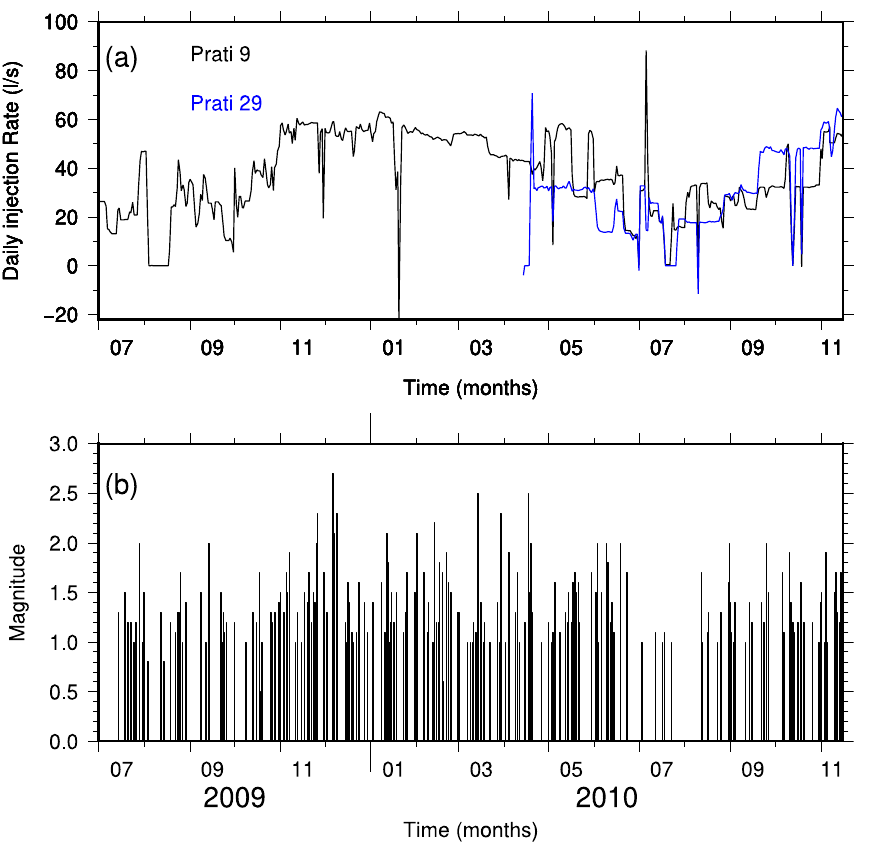
Figure 2. Injection rate and seismicity evolution for the Geysers. ( a ) Daily injection rate at Prati-9 and Prati- 29 injection wells. ( b ) Temporal distribution of the seismicity recorded at The Geysers geothermal field in the period July 2009 November